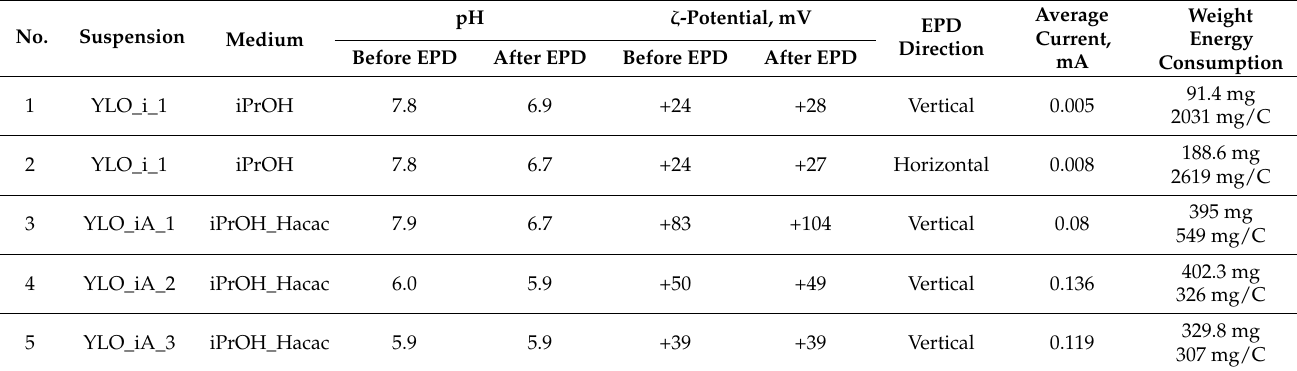
Table 1. Characteristics of the YLO suspensions and EPD conditions.